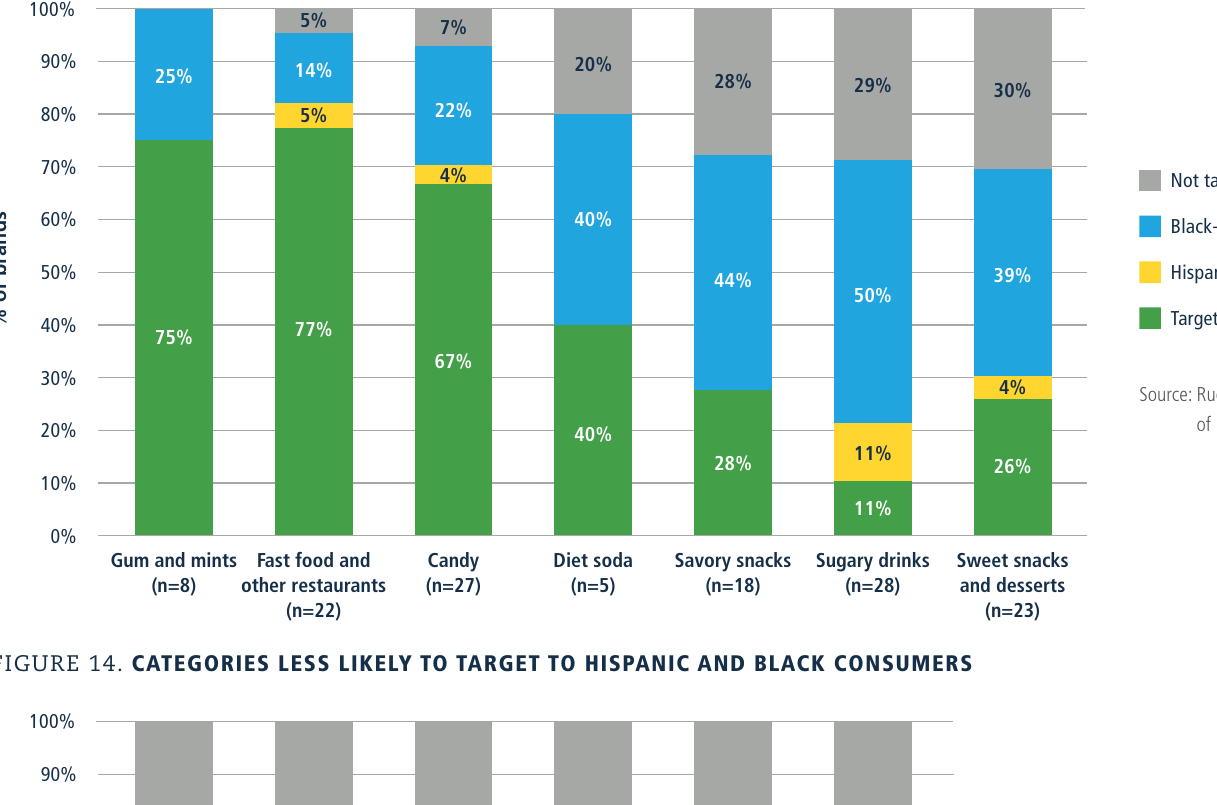
FIGURE 13. CATEGORIES MORE LIKELY TO TARGET TO HISPANIC AND BLACK CONSUMERS